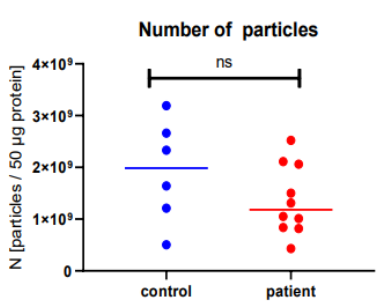
Figure A1. Mean number of MVs standardized to 50 µg protein did not differ significantly between patients (1.37 × 10 9 ; SD ± 6.37 × 10 8 ) and controls (1.92 × 10 9 ; SD ± 9.93 × 10 8 ).